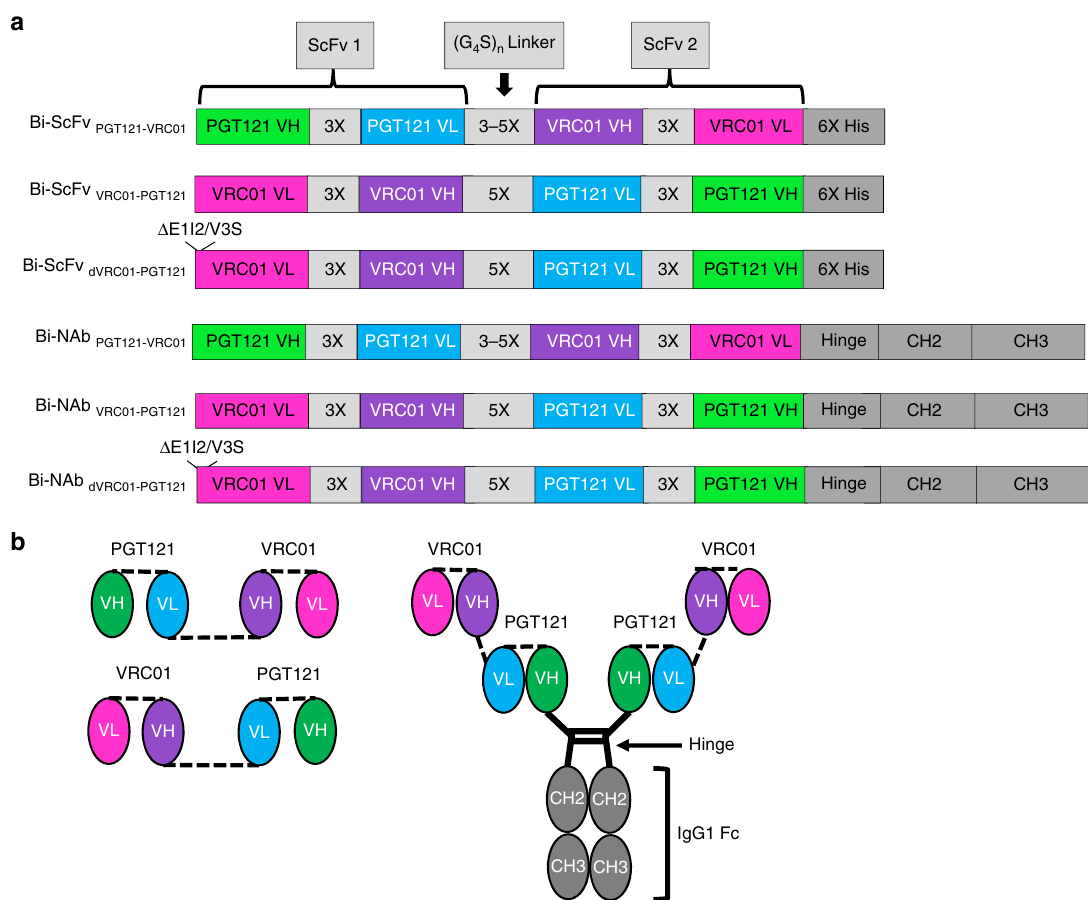
Fig. 2 Bispeci fi c antibody constructs. a Schematic presentation of the Bi-ScFv and Bi-NAb antibody constructs. b Schematic diagram of the molecular con fi gurations of the Bi-ScFv and Bi-NAb